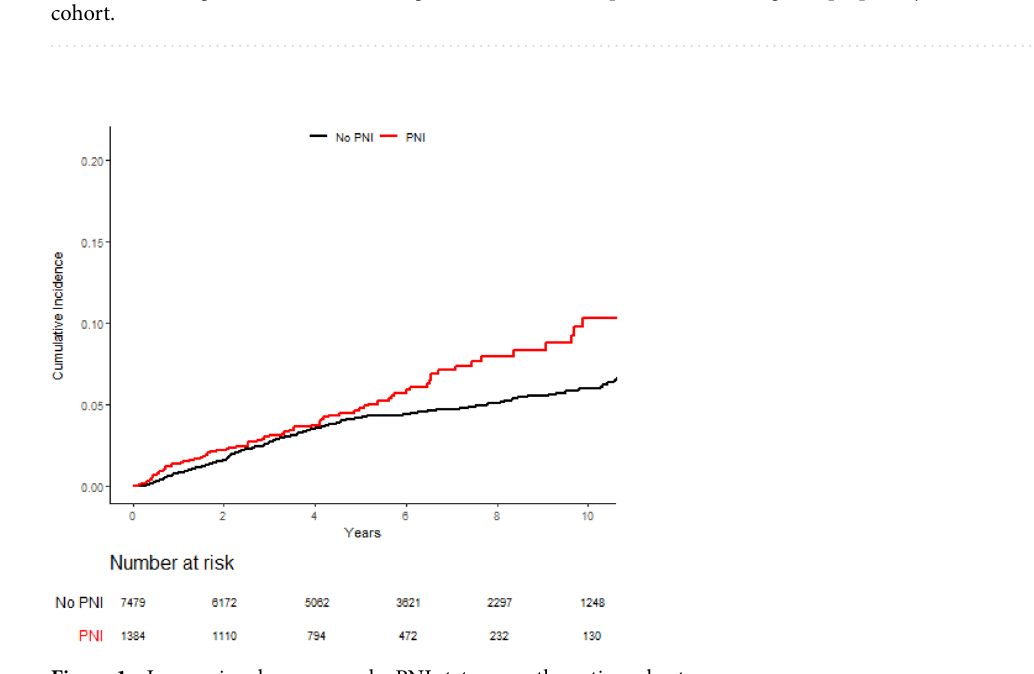
Figure 1. Locoregional recurrence by PNI status over the entire